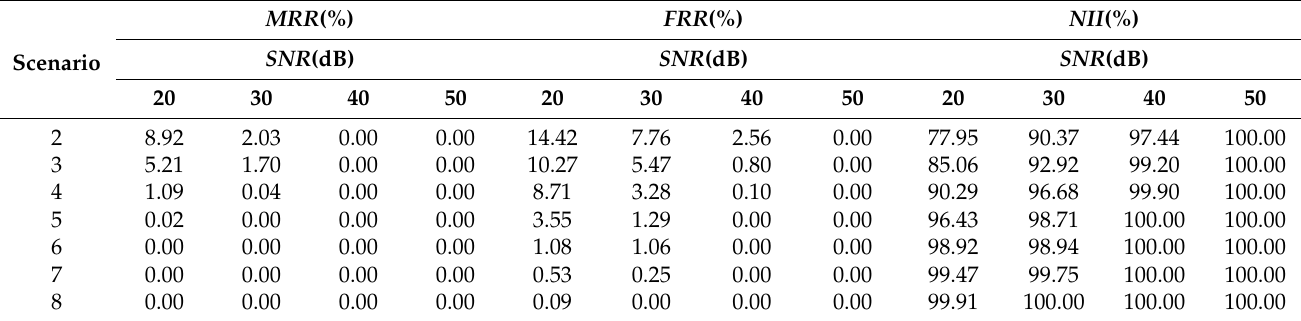
Table 3. EW WPNE noise resistance analysis results.